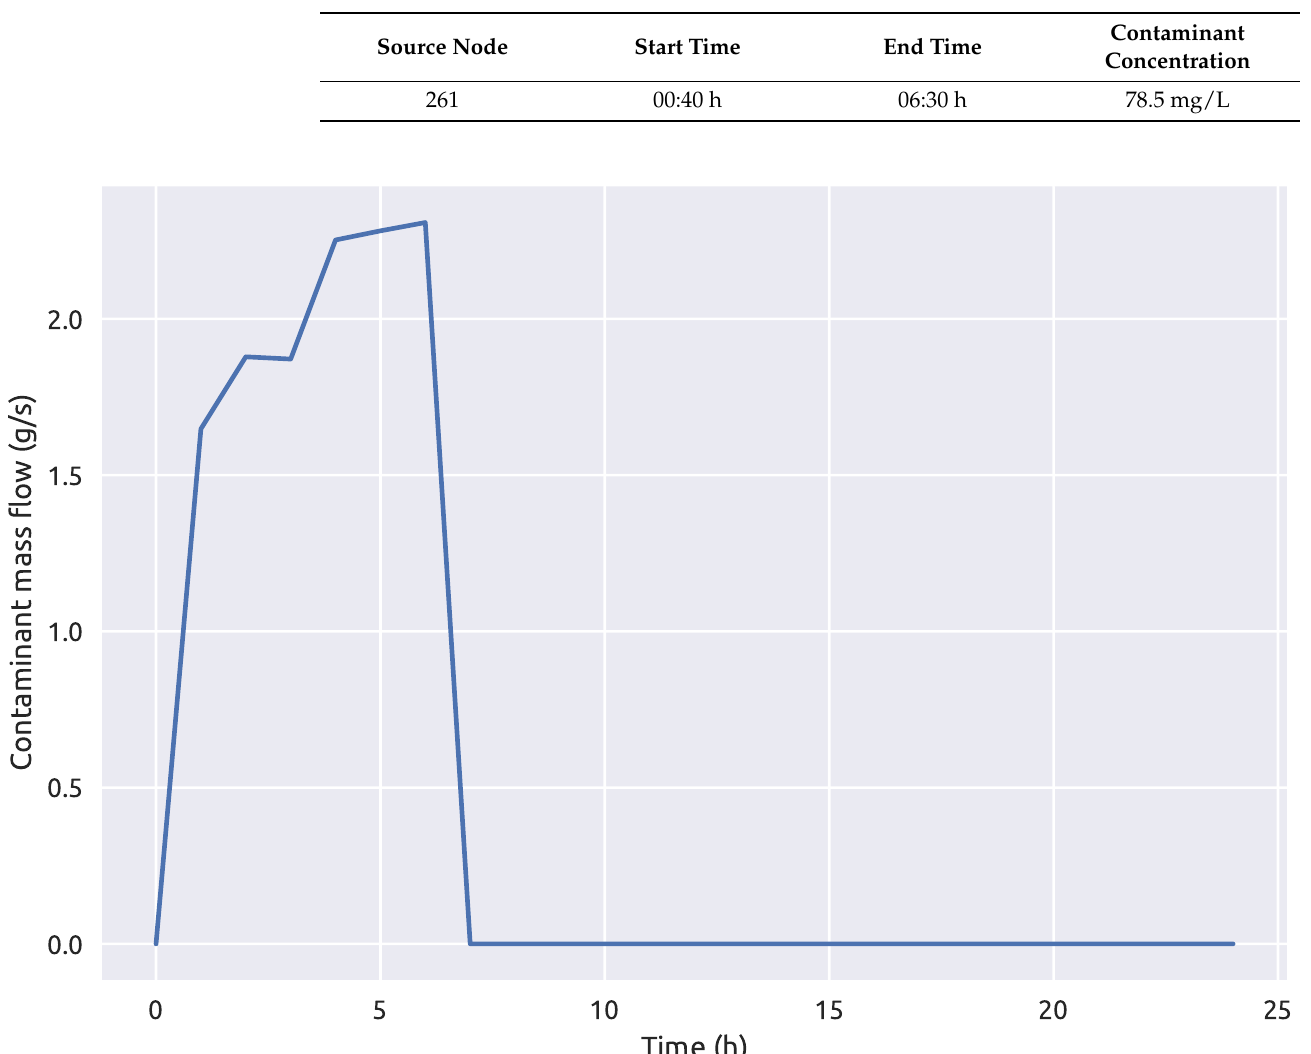
Table 1. NET3 network contamination event parameters.